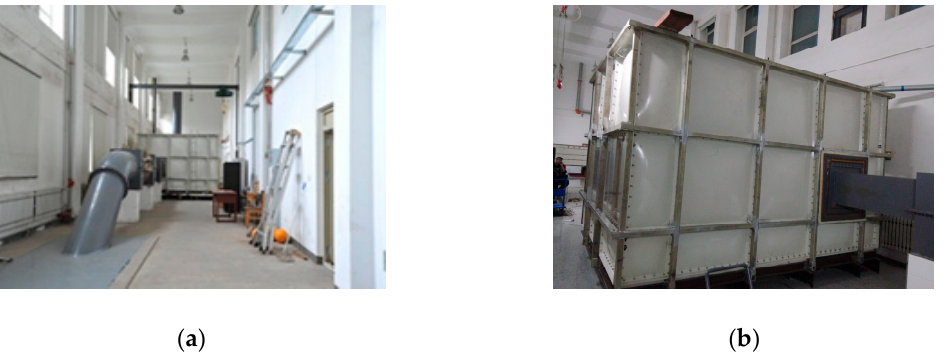
Figure 24. The gravity water tunnel and the reverberation tank. ( a )The whole water tunnel; ( b )The